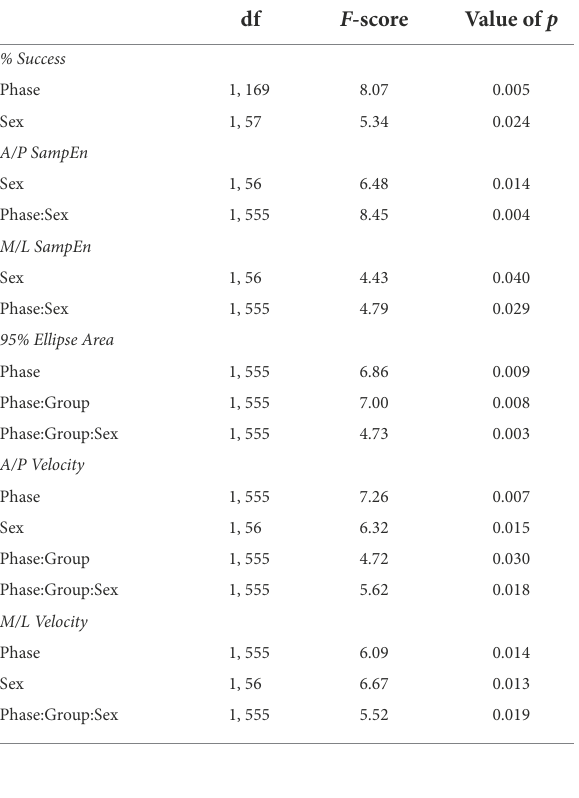
TABLE 2 Summary of significant ANOVA results for balance performance and kinematic variables. df F -score